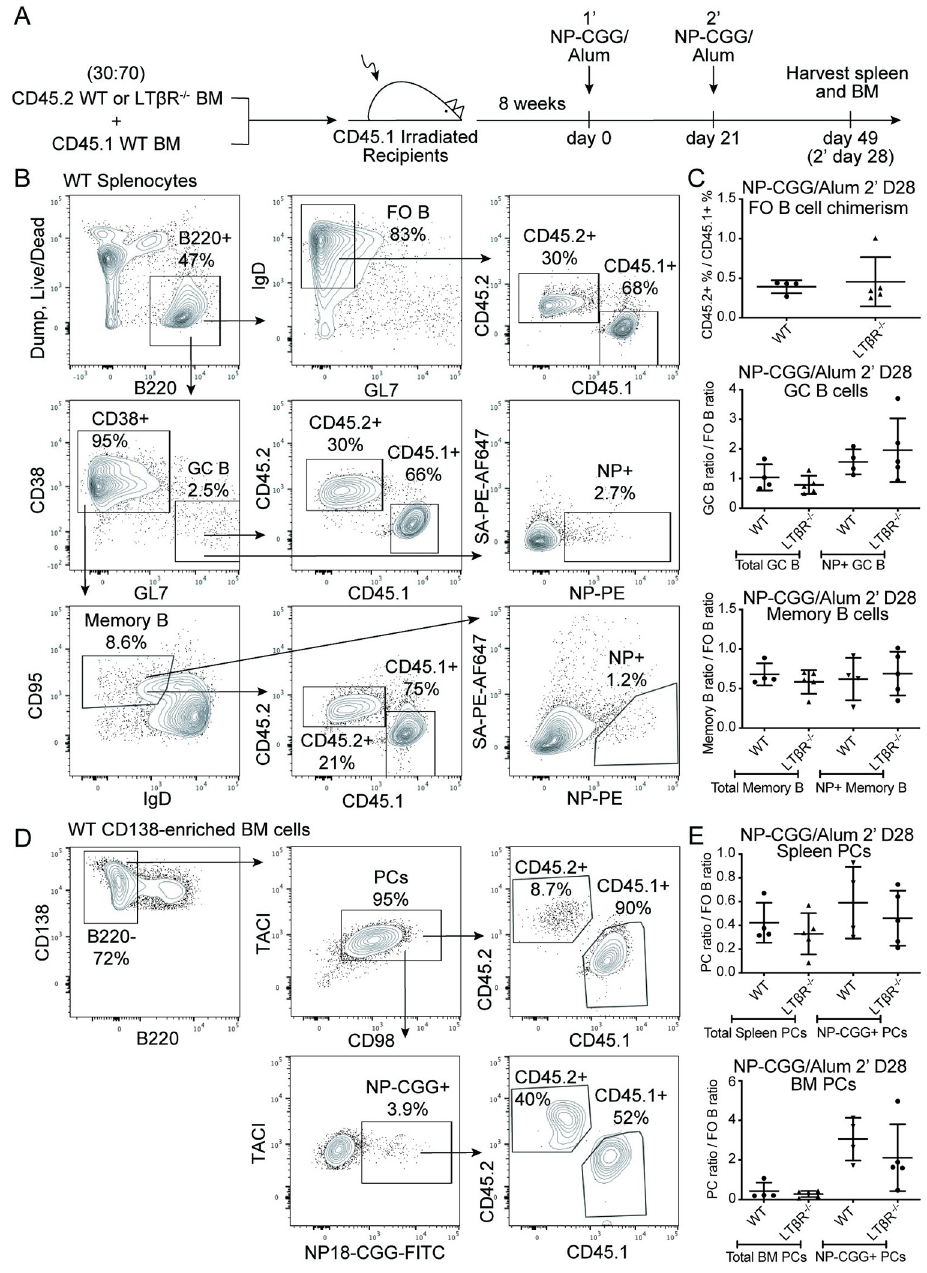
Fig 2. LT β R expression in B cells is not required for PC responses to a T-dependent antigen. (A) Diagram of experimental scheme. Chimeras were made by mixing CD45.2 + WT or Ltbr -/- BM cells with CD45.1 + wild-type cells at a 30:70 ratio and injecting into irradiated CD45.1 + recipients. After 8 weeks of reconstitution, mice were immunized with NP-CGG/Alum two times 21 days apart and analyzed 28 days after the booster immunization. (B) FACS plots of singlet cells with a gate on live Dump - B220 + cells (top row, left). The B220 + cells were further gated on IgD + GL7 - FO B cells (top row, middle), with further gates on CD45.2 + or CD45.1 + cells (top row, right). Alternatively, B220 + cells were gated based on CD38 - GL7 + GC B cells (middle row, left) with further gates on CD45.2 + or CD45.1 + cells (middle row, middle). NP + GC B cells were identified as NP16-PE + and decoy SA-PE-AF647 - (middle row, right). Memory B cells were identified as CD38 + GL7 - CD95 + IgD - (bottom row, left) with gates on CD45.2 + or CD45.1 + cells (bottom row, middle) or NP + memory B cells (bottom row, right). (C) Chimerism based on the ratio of CD45.2 + WT or Ltbr -/- to CD45.1 + WT FO B cells (top). GC B cell ratio of CD45.2 + cells to CD45.1 + cells normalized to the FO B cell ratio (middle). Memory B cell ratio of CD45.2 + cells to CD45.1 + cells normalized to the FO B cell ratio (bottom). (D) Representative FACS plots of CD138-enriched BM cells from a CD45.2 + WT recipient chimera pre-gated on